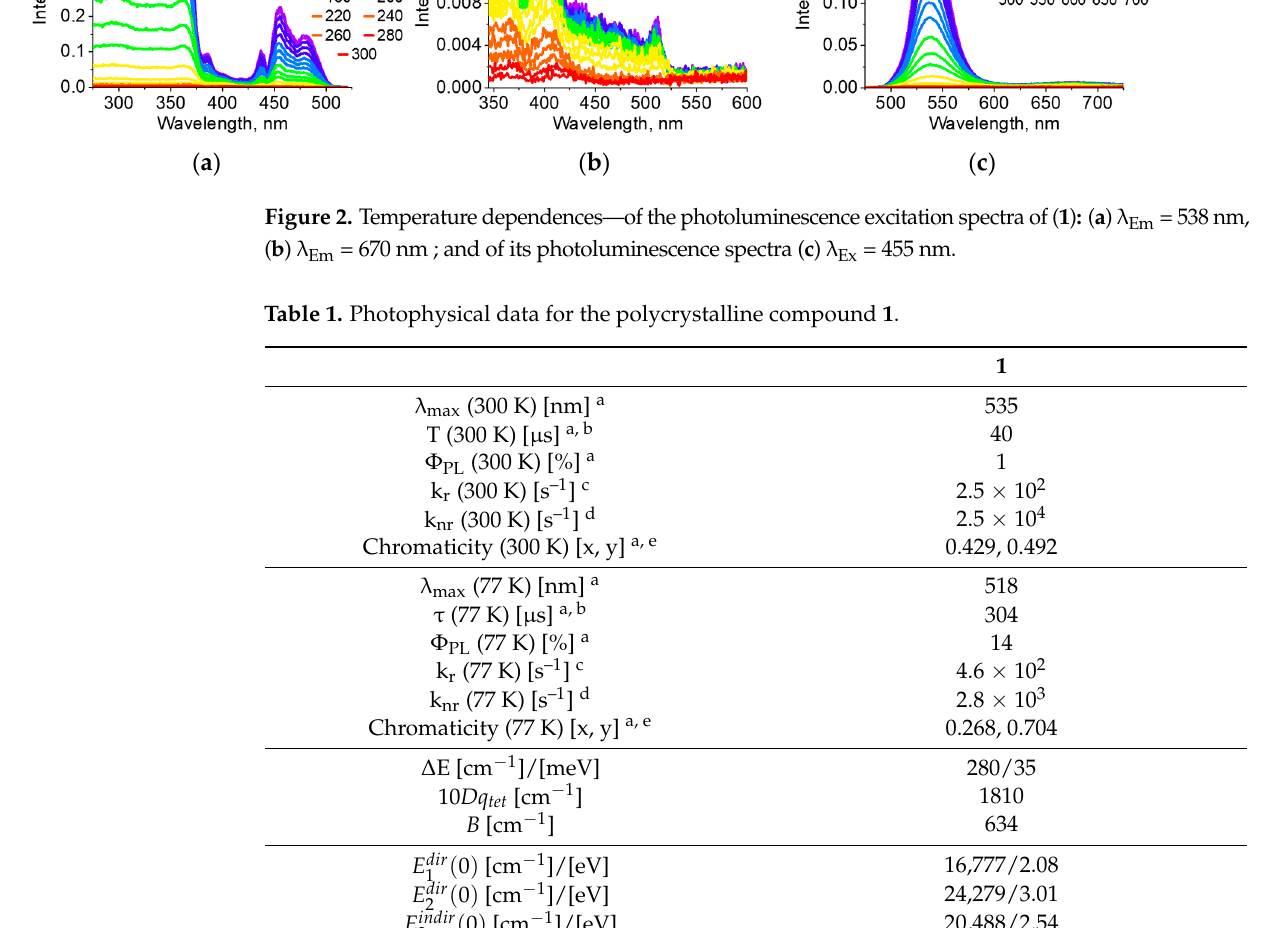
Figure 3. Temperature dependences of the ( a ) photoluminescence linewidth, ( b ) intensity, and ( c ) lifetime ( λ Ex = 455 nm and λ Em = 538 nm) of ( 1 ). Table 1. Photophysical data for the polycrystalline compound 1 .